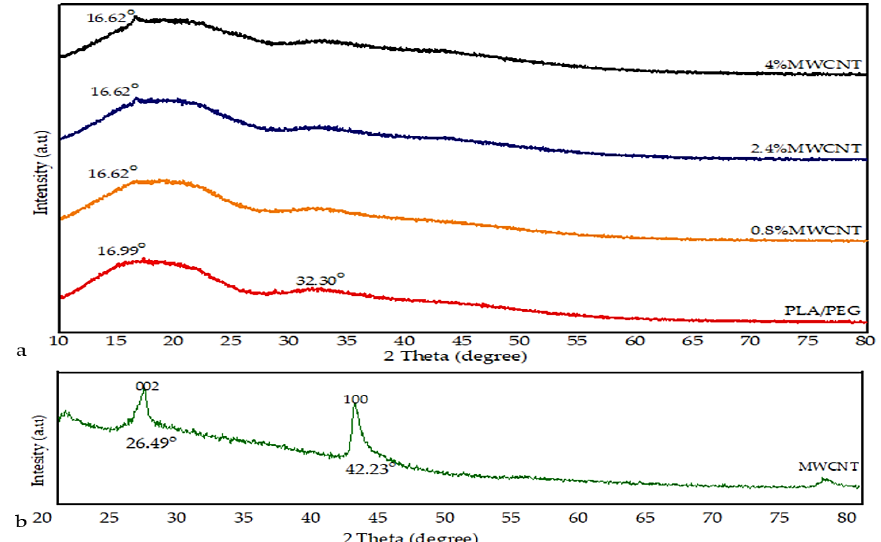
Figure 4. X-ray diffraction (XRD) pattern of ( a ) PLA/PEG, and MWCNT/PLA/PEG nanocomposites with different MWCNTs concentrations, and ( b ) MWCNTs powder.